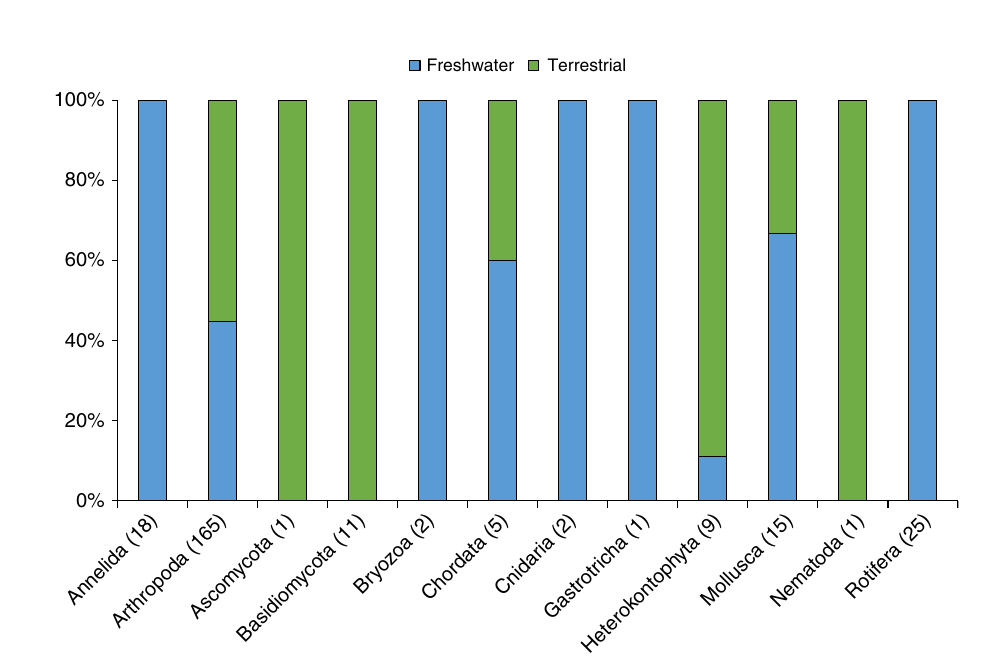
Figure 3 | Percent terrestrial or freshwater species for the subset of each phylum detected in eDNA. Species were confirmed as known to be present in Switzerland or known from all four neighbouring countries (Austria, France, Germany and Italy; N ¼ 255). Number in brackets indicates the number of species confirmed for each